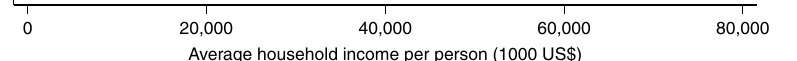
Fig. 5 Water versus electricity demand responses to heat by type. a 95% Con fi dence intervals for the percent increase in water demand against the percent increase in electricity demand, by apartment type, from a + 1 °C variation. The variable of interest, average temperature over the usage period, enters fl exibly interacted with a set of indicators for the different apartment types. The empirical support for average temperature is 26.1 – 29.1 °C. The regression models control for household, time (month, year, day-of-the-week, public holidays, and school holidays), weather (relative humidity, dew point depression, wind speed, and precipitation), and PM 2.5 . I specify interactions between apartment-type indicators and controls for year and school holidays. b Air-conditioner penetration (%) and mean annual household income per person (1000 US$) by apartment type, reported in Table 53 and Chart 2.2c of the 2012/2013 Household Expenditure Survey. Source data for panel b are also provided as a Source Data fi